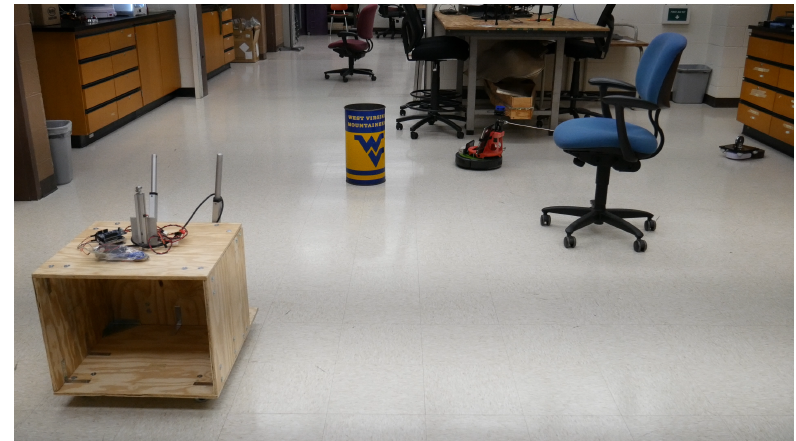
Figure 8. Lab environment used for the experiment.